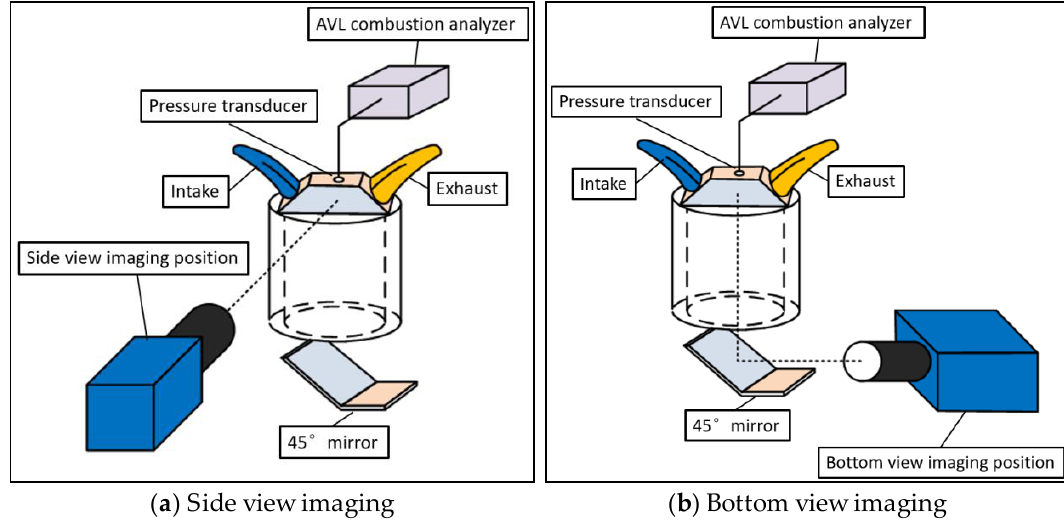
Figure 2. Schematic of the experimental rig.